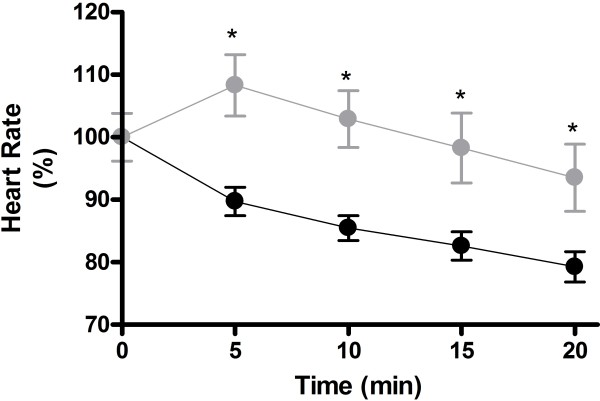
Nicotine effect on sympathetic-stimulated whole-animals. Anesthetized rats (n=10 per group) were treated successively with isoproterenol (0.01 mg/Kg) followed by nicotine (10 μM) at 20 min intervals. Nicotine induced bradycardia in healthy rats (black circles), while inducing tachycardia in chagasic rats (gray squares). *means p < 0.05 when both groups are compared at the indicated time.